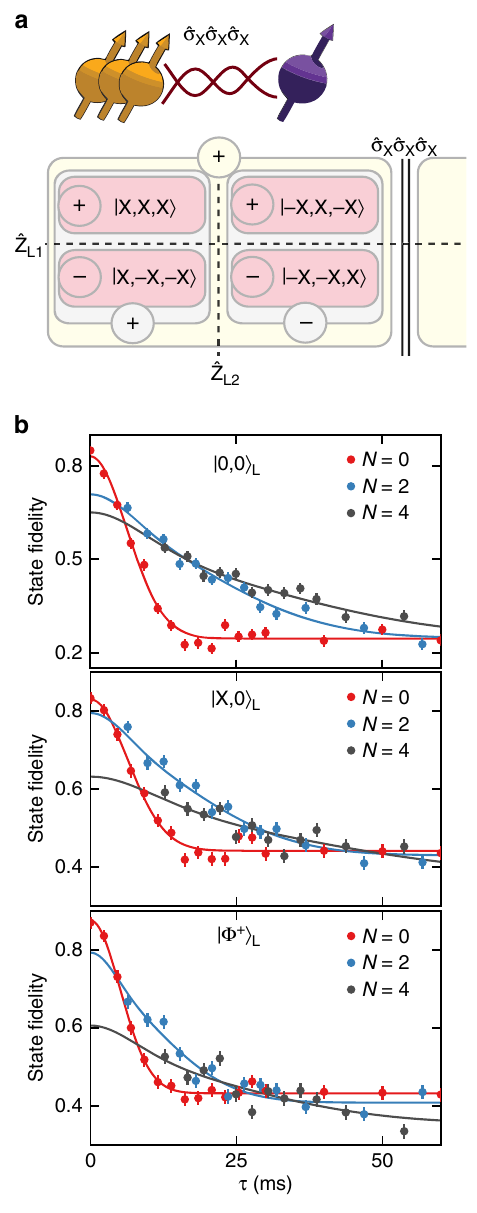
Figure 4 | Two logical qubits in a quantum Zeno subspace. ( a ) Schematic representation for three nuclear spins (spins 1–3) and ^ O ¼ ^ s x ^ s x ^ s x . Two four-dimensional subspaces are created (yellow box). For simplicity we only show the positive subspace, which contains states of the form a X ; X ; j X iþ b (cid:2) X ; X ; (cid:2)j X iþ g X ; (cid:2) X ; (cid:2) X ij þ d (cid:2) X ; (cid:2) X ; X ij . Within this subspace two logical qubits are defined by the logical operators ^ Z L1 ¼ ^ s x ^ I ^ s x , ^ I ^ s ^ Z ^ I ^ s ^ X ^ I ^ s ^ X L1 ¼ z ^ s z and L2 ¼ x ^ s x , L2 ¼ ^ s z z (blue and red boxes). ( b ) Logical state fidelities for three logical states: eigenstate |0,0 i L , superposition state |X,0 i L , and the entangled state | F þ i L . The results show that repeated projections of the three-spin operator ^ O ¼ ^ s x ^ s x ^ s x preserve the two logical qubits while inhibiting dephasing. Solid lines are fits to equation (3). The fidelities decay to different values for large t because | F þ i L and |X,0 i L are eigenstates of operators of the form ^ I ^ s z ^ s z or one of its permutations, whose expectation values are unaffected by dephasing. Error bars are 1 s.d.